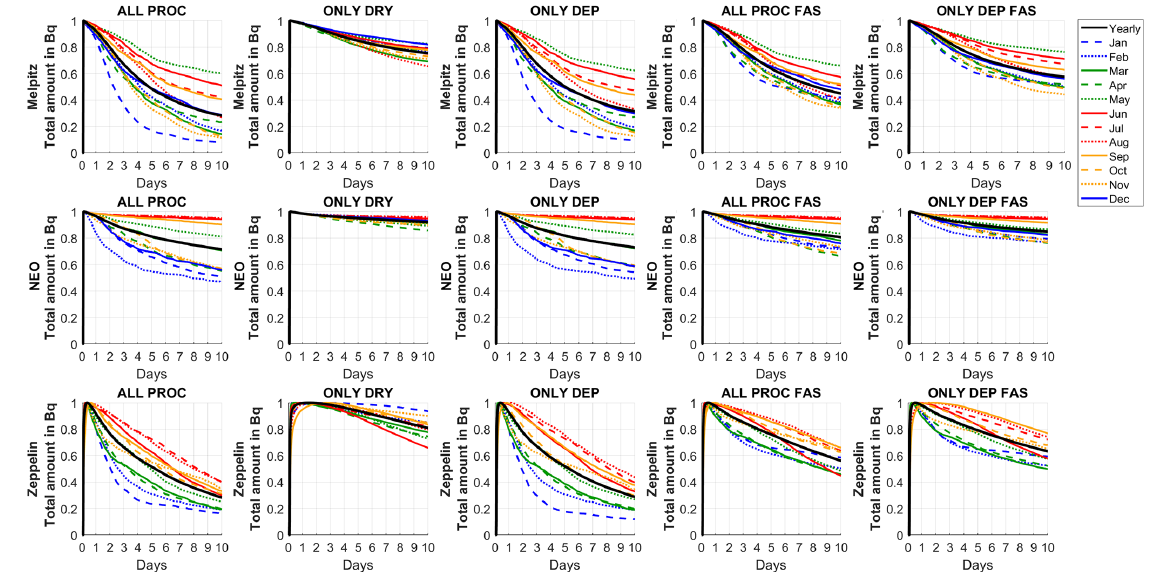
Figure 5. Annual (black) and monthly means (blue for winter, December–February; green for spring, March–May; red for summer, June– August; and orange for autumn, September–November). Development of caesium concentration as normalized Becquerel values for the five different experiments. Each row represents a different station (from the top, Melpitz, NEO and Zeppelin), and the columns are the different experiments, ALL PROC, ONLY DRY, ONLY DEP, ALL PROC FAS and ONLY DEP FAS.